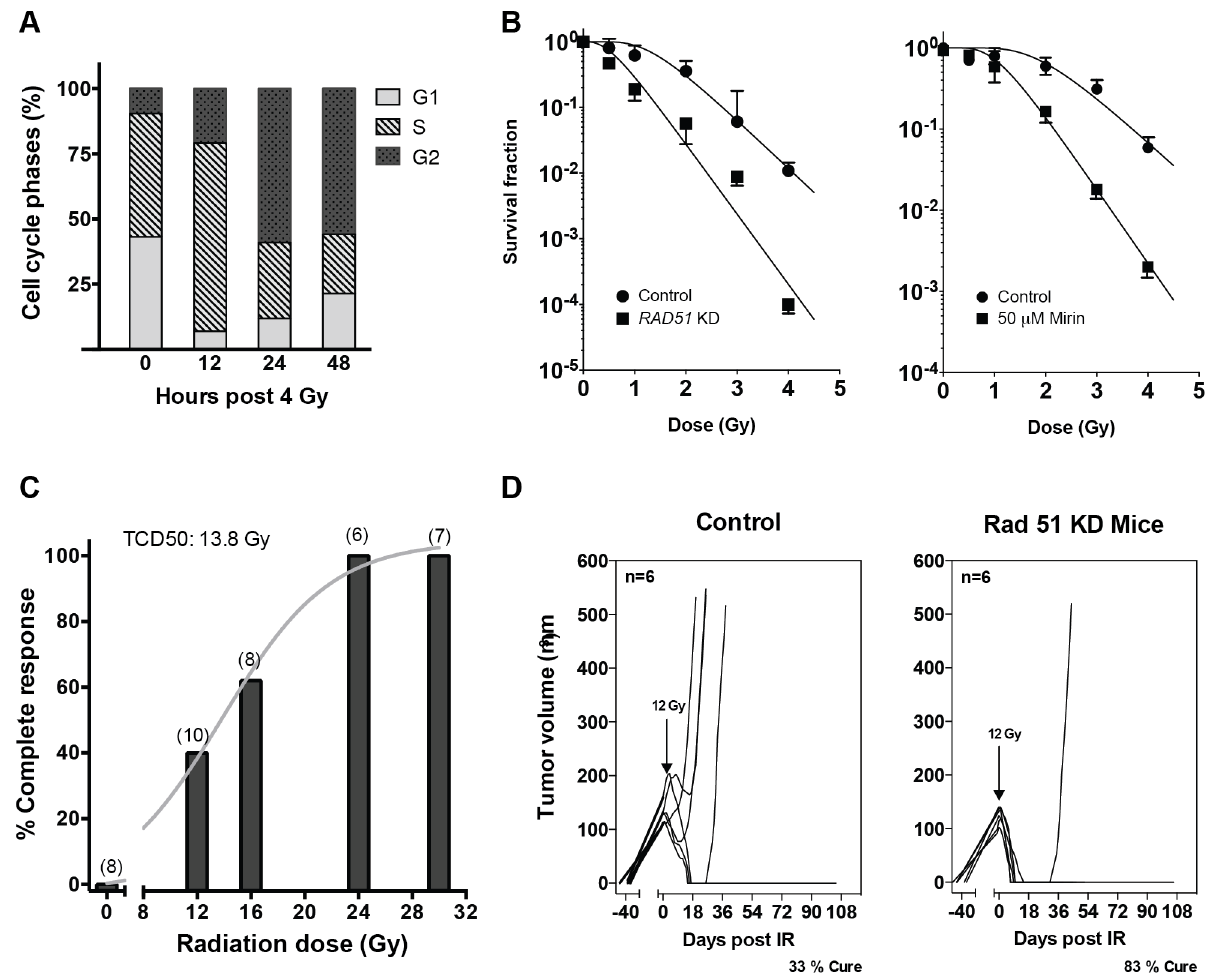
Fig 4. HDR inactivation radiosensitizes human Notch-driven cancer. (A) Cell cycle distribution of unirradiated and 4Gy-treated CUTLL-1 cells. DNA content was assessed by propidium iodide incorporation and FACS analysis. (B) Targeting RAD51 or inhibiting the Mre11-Rad50-Nbs1 complex radiosensitizes CUTLL-1 cells. Clonogenic survival was performed in CUTLL-1 cells expressing human RAD51 shRNA or non-silencing control shRNA (left), or in cells treated with or without 50 μ M Mirin (right). Surviving colonies ( > 50 cells ) were scored at 11 – 14 days post irradiation. Data represent three independent experiments for each assay. (C) Complete CUTLL-1 tumor response after single dose radiotherapy. CUTLL-1 chloromas (100 – 150 mm 3 ) in flanks of NOD-SCID female mice were irradiated, and tumor volumes were measured using calipers 2x weekly for 3 months. Complete response was defined as lack of measurable tumor. Parentheses denote number of mice ⁄ group. The curve was fit to data by nonlinear regression analysis using the Prism Sigmoidal Curve Fit program. (D) RAD51 inactivation radiosensitizes Notch-driven tumors. NOD-SCID female mice harboring RAD51